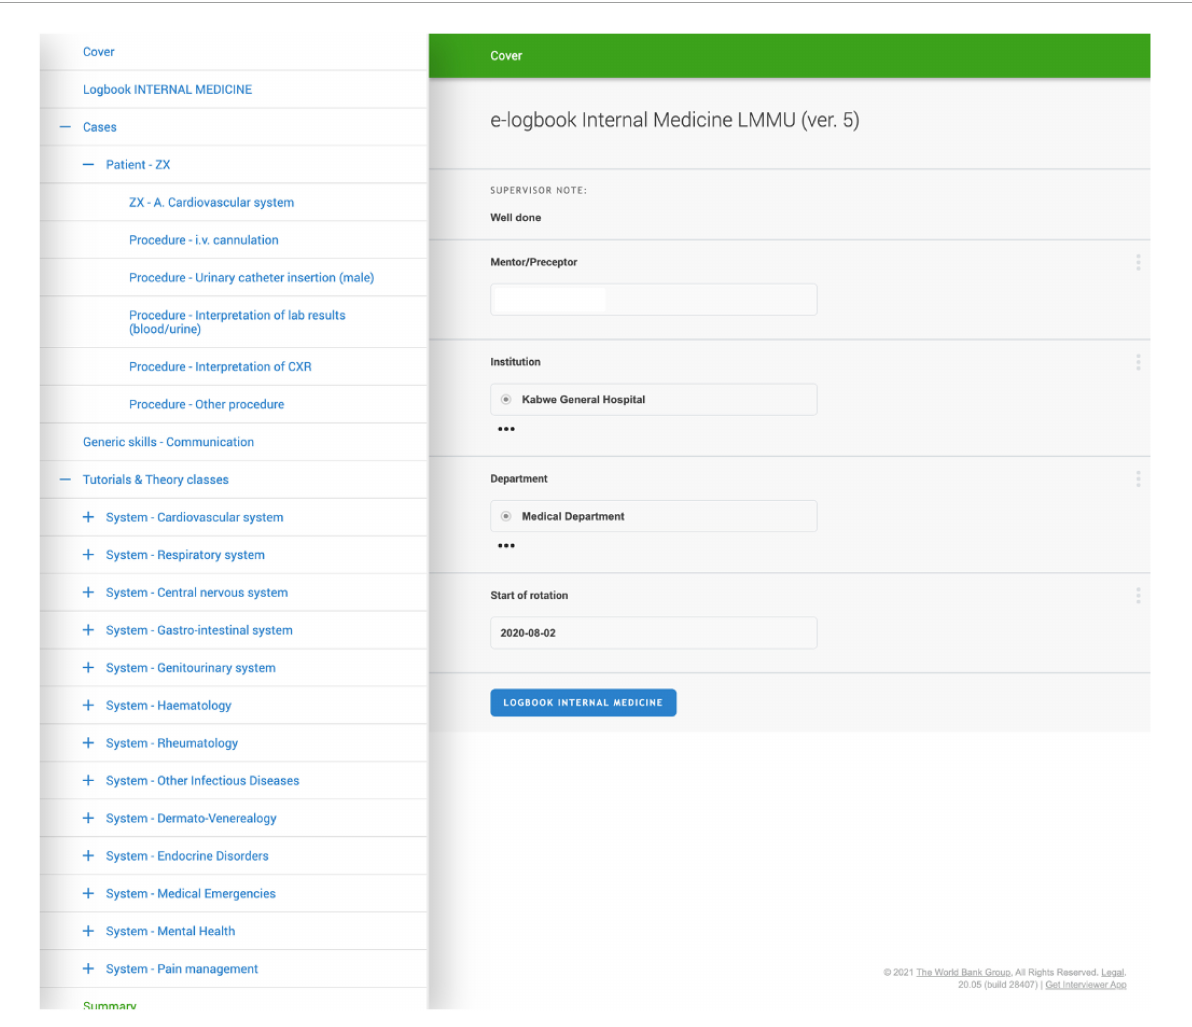
FIGURE3 E-logbook for the internal medicine practical rotation showing the first page of a case report of patient ZX, whereby the student performed procedures in intravenous cannulation, urinary catheter insertion, interpretation of lab results, interpretation of chest radiograph and another procedure. On the left is an illustration of the e-logbook’s content